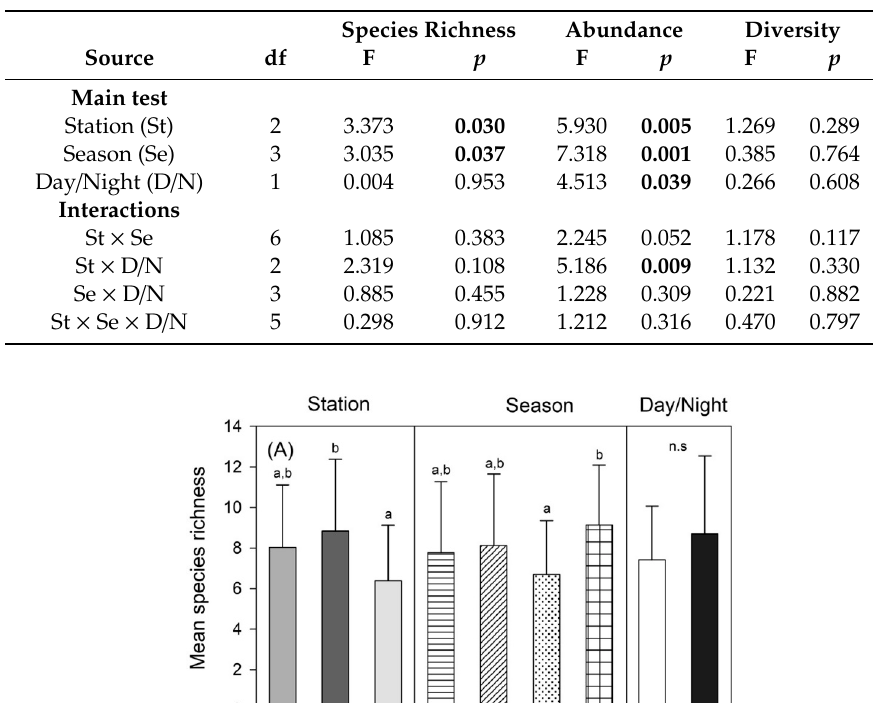
Table 2. Abundance (100 m − 2 ), number of species, and diversity three-way ANOVA for decapod assemblages in South Korea. Boldface values are significance at p < 0.05.